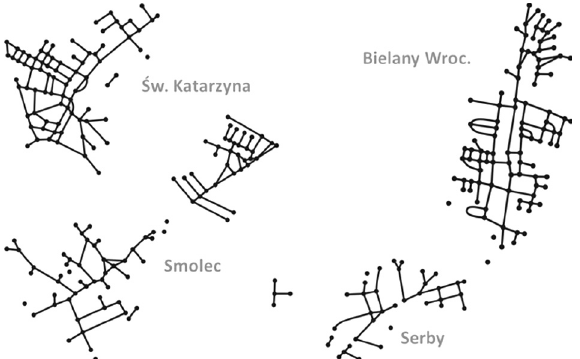
Fig. 12. Graphs depicting the morphology of suburban villages (SV). Source: own work.